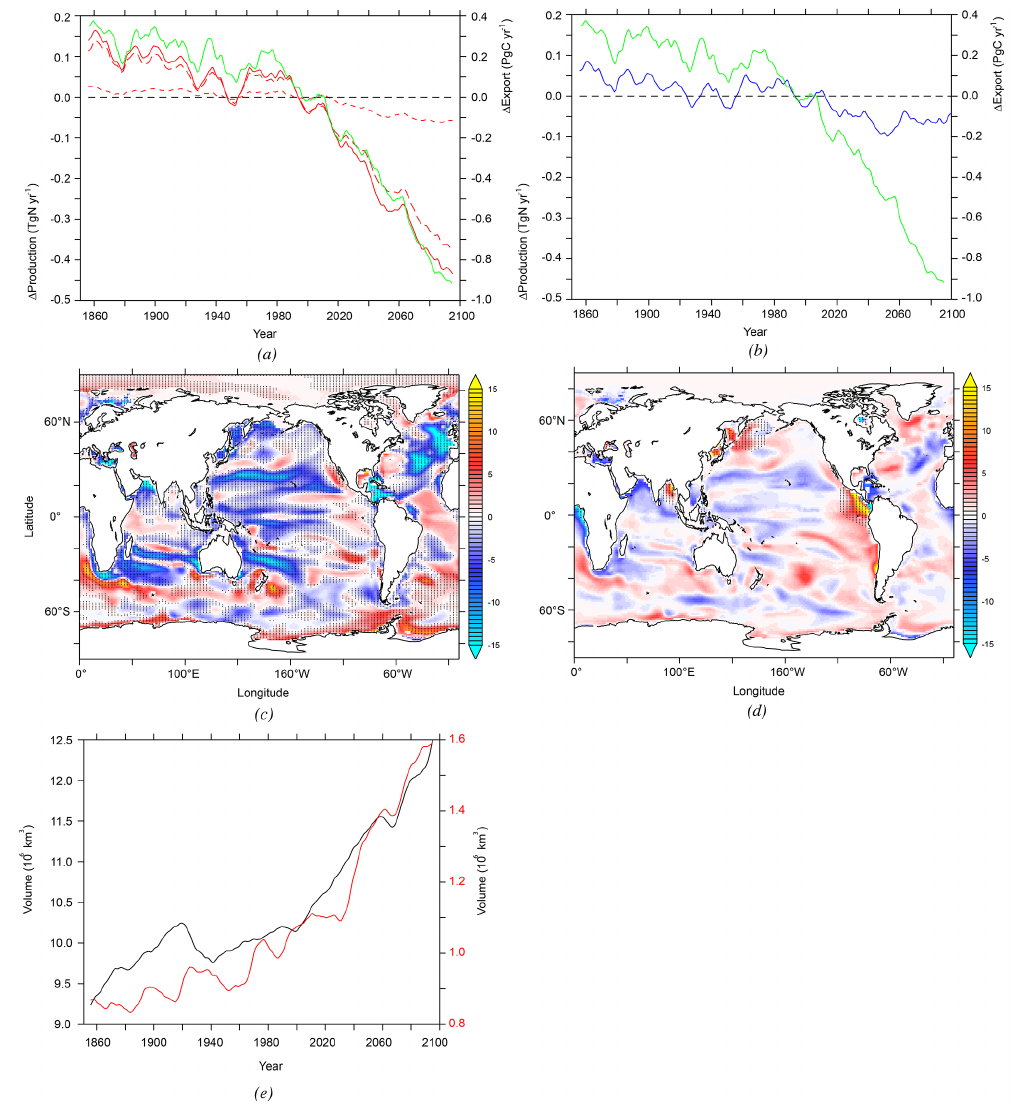
Figure 5. (a) Anomalies in export of organic matter at 100m (green), low-O 2 production pathway (short dashed red), high-O 2 produc- tion pathway (long dashed red) and total P.OMZ production (red) from 1851 to 2100 using the historical and future RCP8.5 simulations. (b) Anomalies in export of organic matter at 100m (green) and P.TEMP production (blue) over the same time period. (c) Change in high-O 2 production pathway of N 2 O (in mgNm − 2 yr − 1 ) in the upper 1500m between the 2080–2100 and 1985–2005 averaged time periods. Hatched areas indicate regions where change in export of organic matter at 100m deep have the same sign as in changes in high-O 2 production path- way. (d) Change in low-O 2 production pathway of N 2 O (in mgNm − 2 yr − 1 ) in the upper 1500m between the 2080–2100 and 1985–2005 averaged time periods. Hatched areas indicate regions where oxygen minimum zones (O 2 <5µmolL − 1 ) expand. (e) Volume (in 10 6 km 3 ) of hypoxic (black, O 2 <60µmolL − 1 ) and suboxic (red, O 2 <5µmolL − 1 ) areas in the 1851 to 2100 period in NEMO-PISCES historical and future RCP8.5